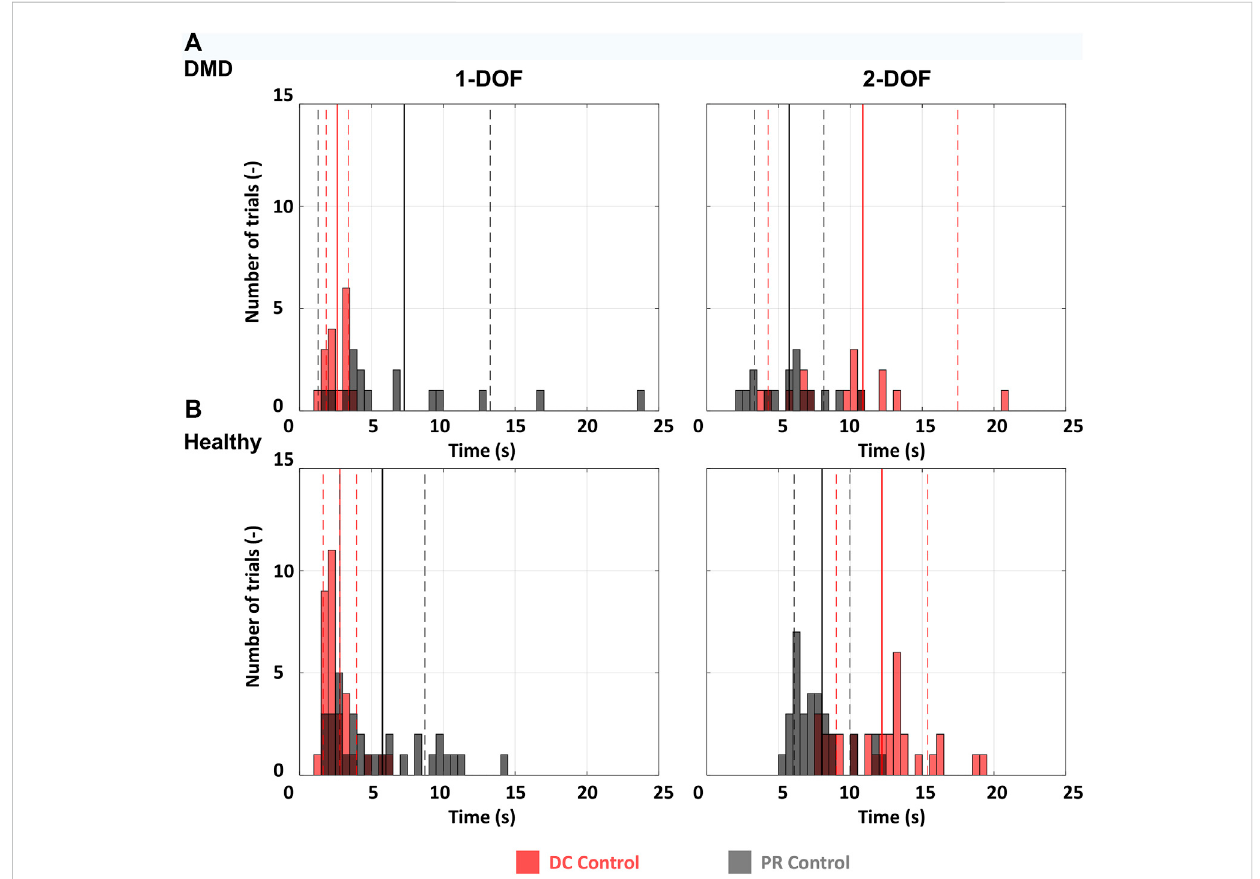
FIGURE 3 Histograms for all participants. 1-DOF and 2-DOF tasks were compared separately. (A) The distribution of reaching times for all 1-DOF and 2-DOF tasksfortheparticipantwithDMD.SinceeveryDOFincludestwotargetsandeachtargetwasperformed8times,wehave16eventsperhistogram. (B) The average distribution of reaching times for all 1-DOF and 2-DOF tasks for the ten healthy participants. Since every DOF includes four targets and each target was performed 8 times, we have 32 events per histogram. The full vertical lines represent the mean and the dashed the standard